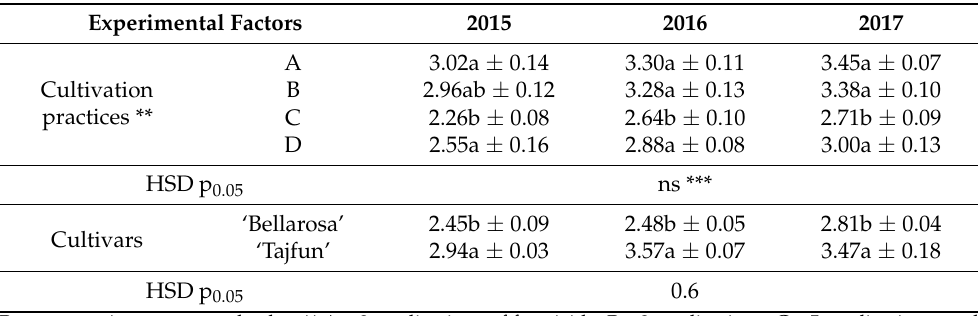
Table 7. Effects of cultivation practices, cultivars, and years on the a* parameter of raw tubers. Experimental